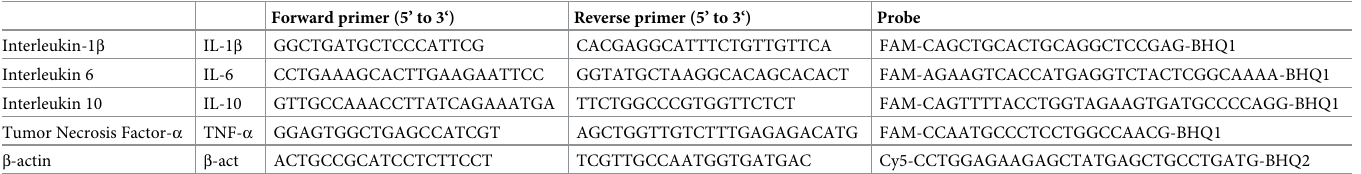
Table 1. Detailed sequence information of the primers and probes for qRT-PCR. Forward primer (5’ to 3‘) Reverse primer (5’ to 3‘)